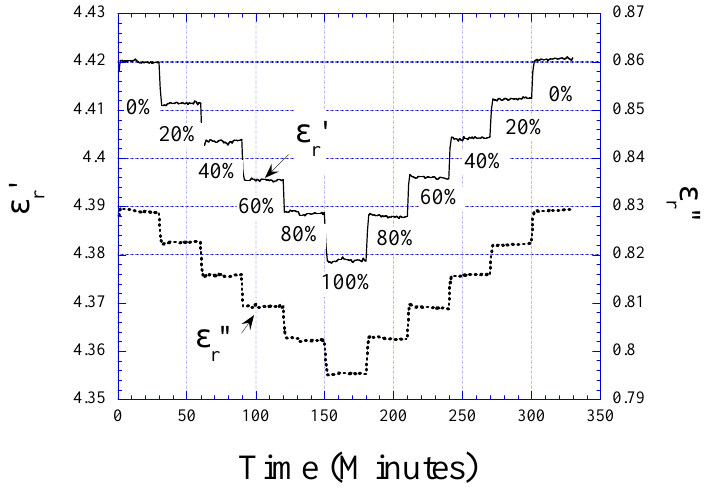
Figure 7. Measured ε varying from 0% (volume) to 100% and then back to 0%. The shifts are linear, with ∆ε 0.0004043/%CO